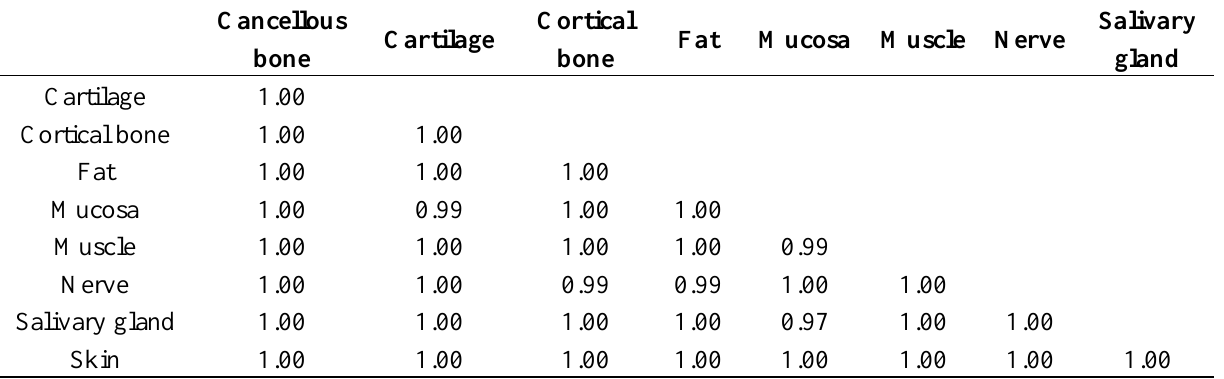
Table 3. Areas under the ROC curve